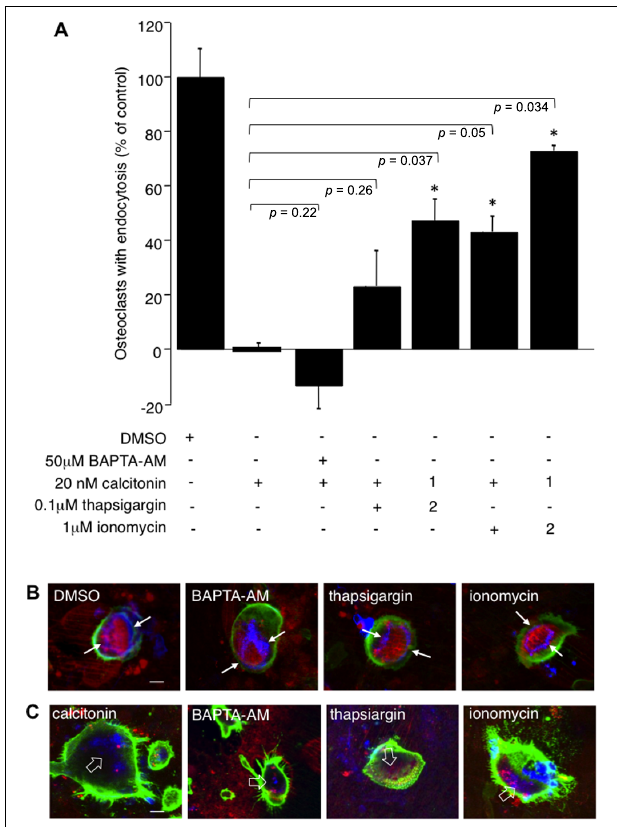
FIGURE 4 | Calcium fluctuations are essential for endocytic trafficking from the ruffled border. Rabbit osteoclasts plated on dentine for 16 h were incubated with 20 nM calcitonin and indicated concentrations of calcium modulators for 30 min before the addition ofTRITC-dextran 3,000 for 5 min and fixation. 1 μ M ionomycin or 100 nM thapsigargin were either added together with calcitonin (1) or were added 1.5 min after addition of calcitonin (2). (A) Chart showing the effects of different inhibitors.The number of osteoclasts presenting endocytosed dextran was counted after immunodecoration with antibodies directed against the α v β 3 integrin and expressed as percentage of total. Columns show mean percentage of osteoclasts with dextran endocytosis in comparison to calcitonin treatment alone (set to 0). Error bars represent SD, significant increases in dextran endocytosis over calcitonin treatment are marked: * p < 0.05, individual p -values are shown above the bars. (B) Morphology of the actin-cytoskeleton after exposure to calcium modulators. Rabbit osteoclasts plated on dentine were exposed for 30 min to 50 μ M BAPTA-AM; 1 μ M ionomycin; 100 nM thapsigargin before addition of TRITC-dextran 3,000 for 5 min, fixation and immunodecoration. Red, TRITC-dextran; green, anti- α v β 3 antibodies; blue, actin cytoskeleton.The resorption area enclosed by the actin ring is indicated with arrows. (C) Osteoclasts on dentine were incubated for 30 min with 20 nM calcitonin together with 50 μ M BAPTA-AM; 1 μ M ionomycin or 100 nM thapsigargin. Red,TRITC-dextran; green, anti- α v β 3 antibodies, blue, actin-cytoskeleton. Disorganized actin filaments in the cells treated with calcitonin are highlighted with open arrows. Scale bars: 10 μ